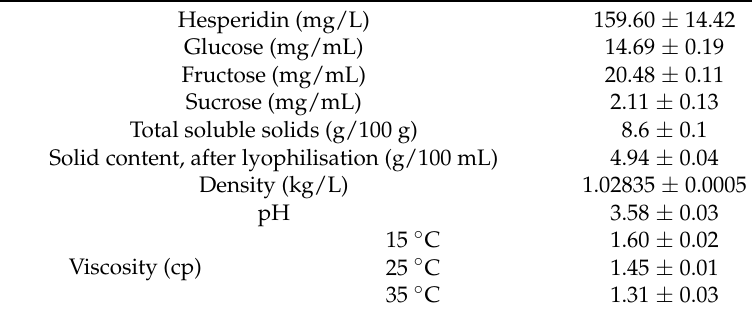
Table 1. Physico-chemical characteristics of orange press